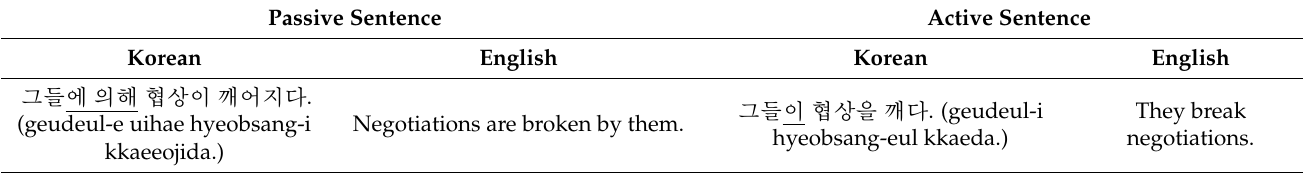
Table 6. One Example of Converting Passive Sentence to Active